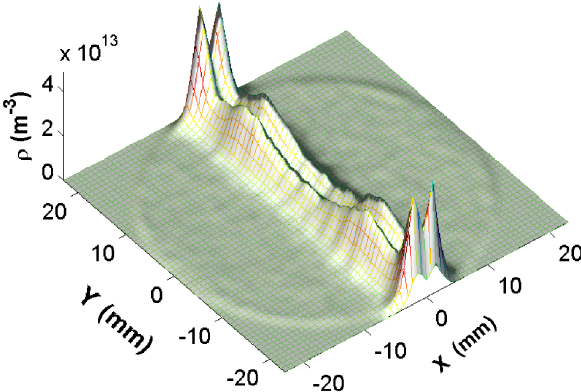
FIG. 16. The clearing electrode electric field in the simulated wiggler vacuum chamber for an electrode voltage of 500 V. The top plot shows the field vectors. The bottom plot shows equipotential lines labeled in units of